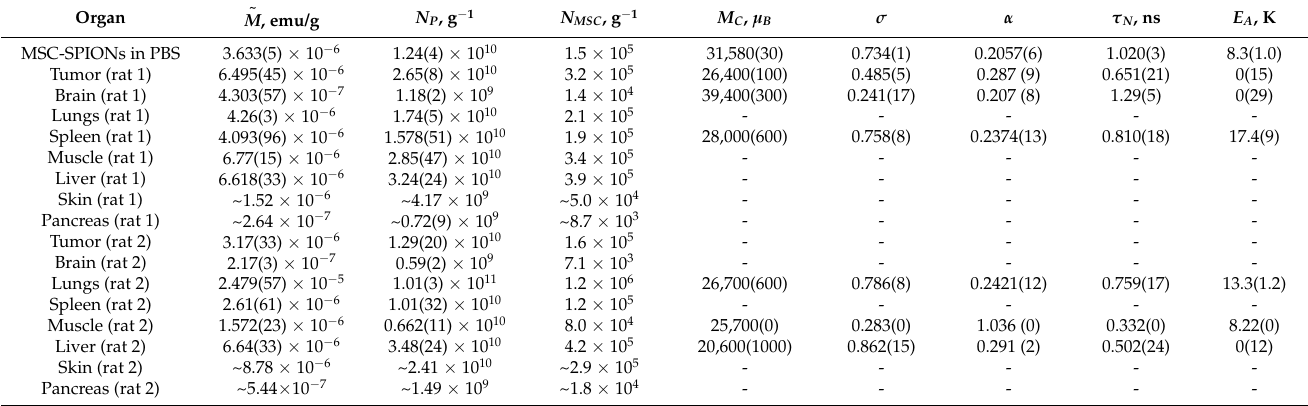
Figure 5. Real and imaginary parts of the nonlinear magnetic response as functions of the dc magnetic field direct (filled red and magenta symbols) and reverse (open olive and cyan symbols) scans (indicated additionally by arrows of the same with symbols colours) at F sc = 8 or 0.25 Hz, with their best fits are displayed for brain, lungs, liver (panel A ), and tumor, spleen, muscle (panel B ) following one day after intravenous injection of SPION-labeled MSCs. Only every 10th experimental point is shown. Obtained parameters are presented in Table 1. Table 1. Parameters of M2 signals and biodistribution of SPION-labeled MSCs in rats.